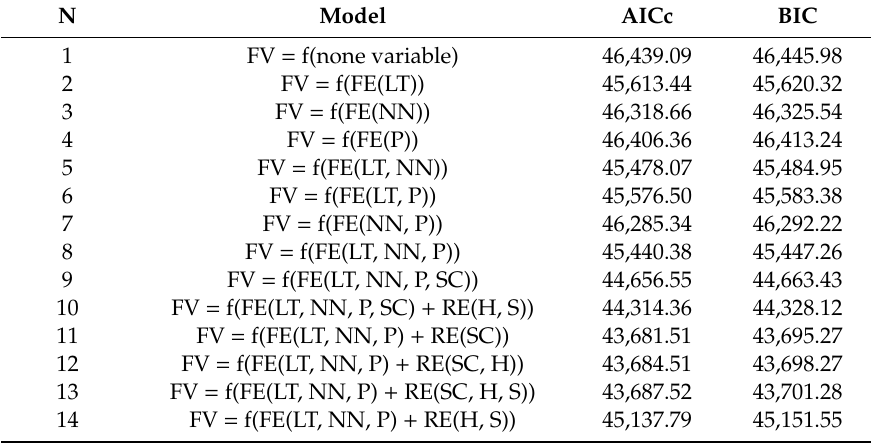
Table 2. Corrected Akaike (AICc) and Bayesian (BIC) information criteria for proposed and numbered models (N). FE: fixed effects. RE: random effects. LT: liquid level in the tank. NN: number of active nozzles. P: circuit pressure. SC: section of the measured points. S: side. H: height. The first model is null.